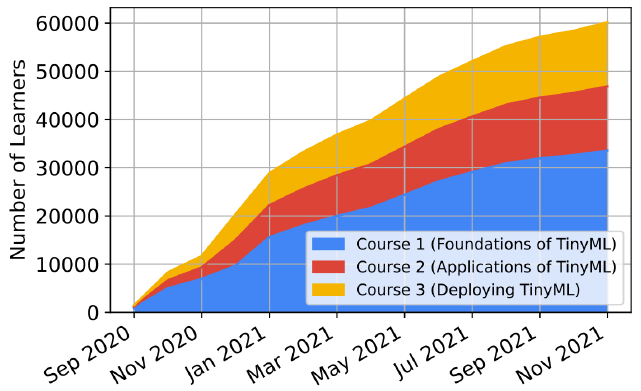
Figure 12. Course-enrollment metrics for Courses 1 through 3. Over 60,000